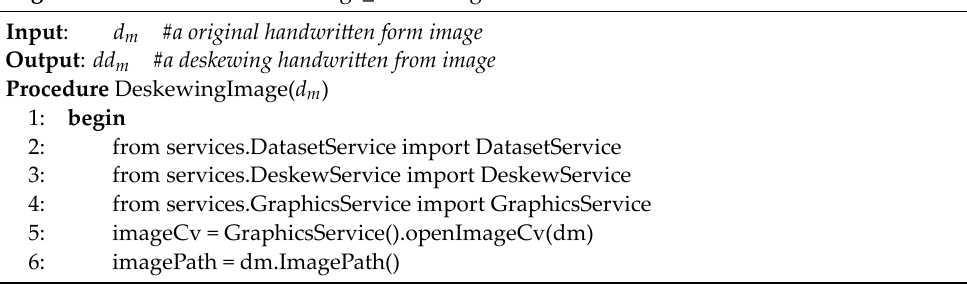
Algorithm 1: Pseudo‑code of